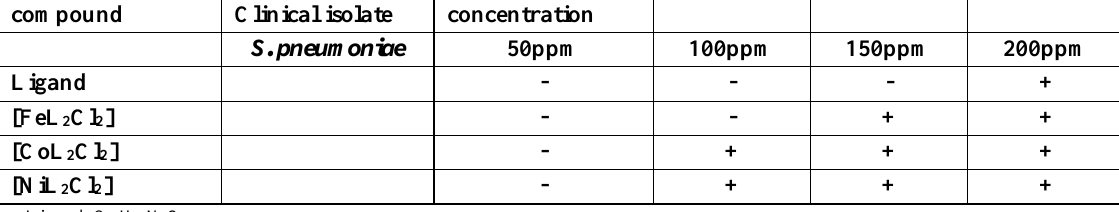
Table 8. Minimum inhibitory concentration (MIC) of Schiff base ligand and its metal complexes compound